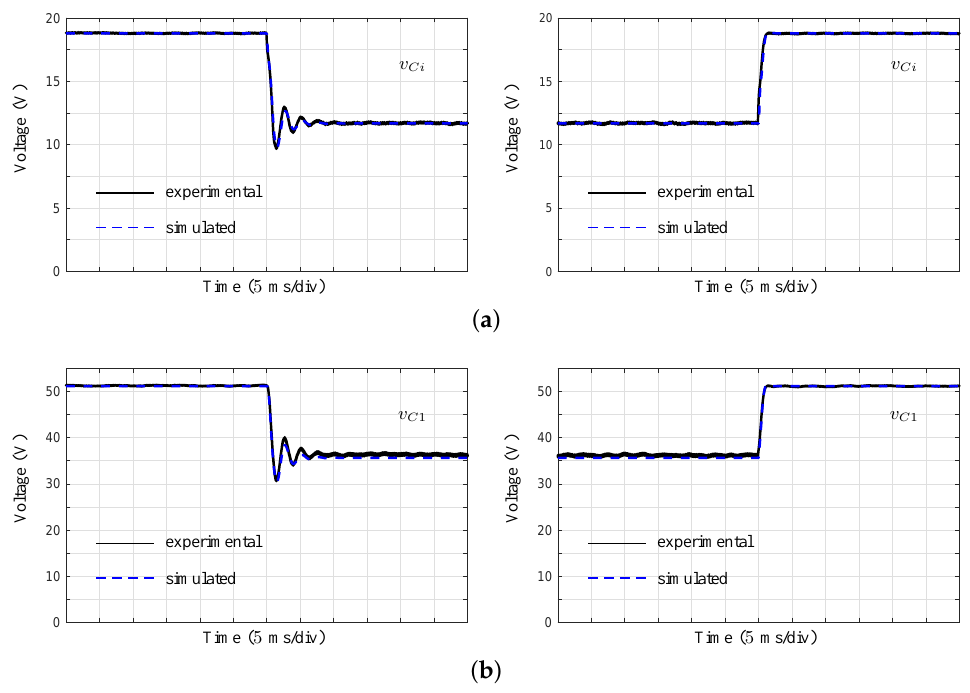
Figure 20. Simulation and experimental results of the transient responses of the converter under duty ratio steps. ( a ) Voltage in capacitor C i (time: 5 ms/div). ( b ) Voltage in capacitor C 1 (time: 5